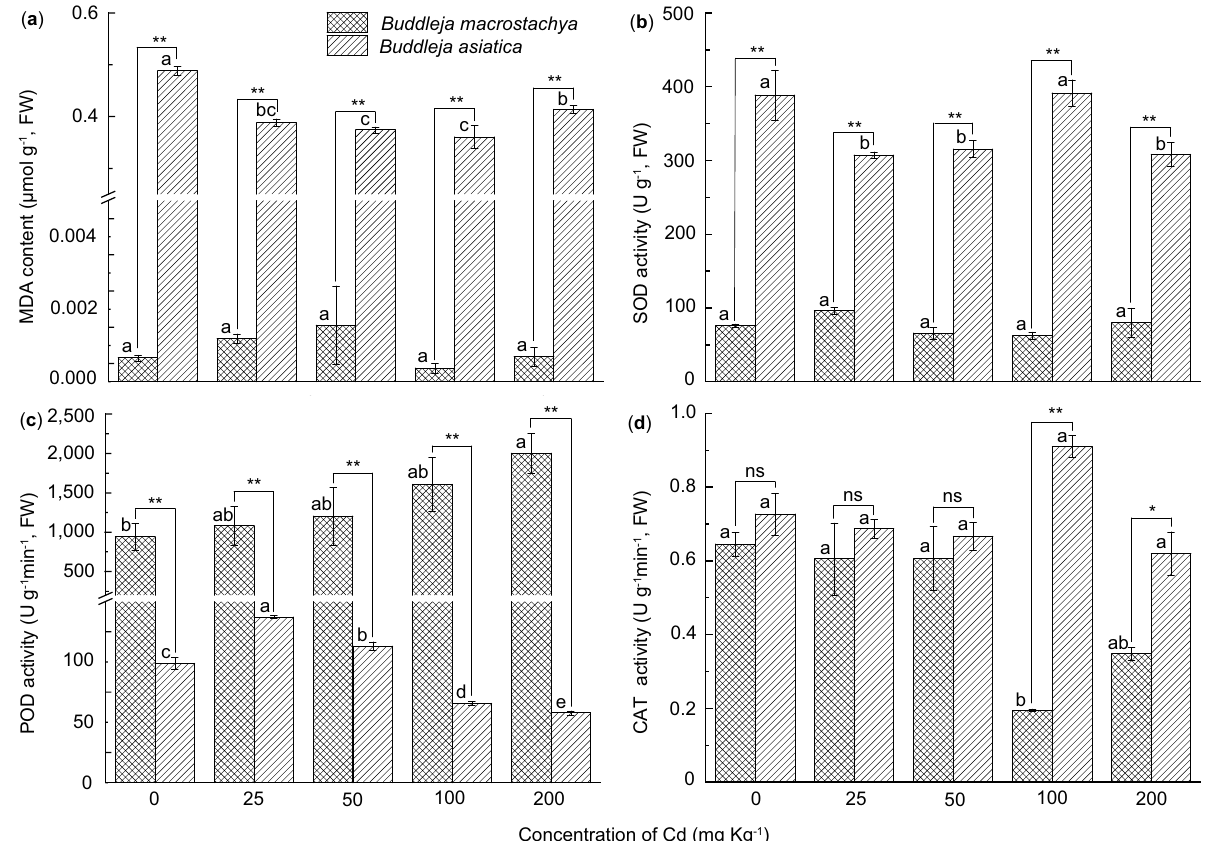
Figure 2. The effects of Cd treatments on ( a ) MDA content, ( b ) SOD activity, ( c ) POD activity, and ( d ) CAT activity in the leaves of B. asiatica and B. macrostachya . Values are represented as the mean ± S.E. (n = 3). Different letters indicate significant differences between different Cd treatments according to LSD-tests ( p < 0.05); Asterisks indicate significant differences between different species at the same Cd level according to